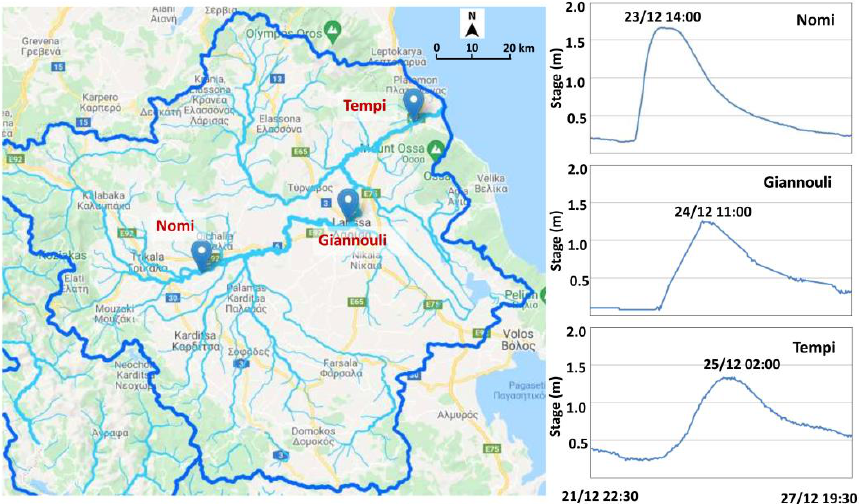
Figure 8. Space – time evolution of Pinios river stage. Figure 8. Space–time evolution of Pinios river